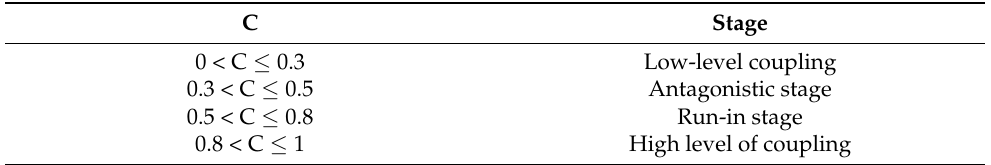
Table 4. Coupling measurement standard